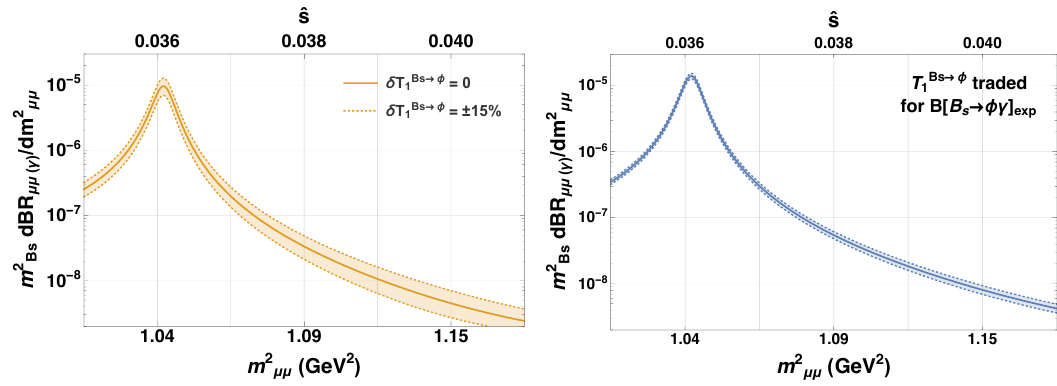
Figure 3 . Di(cid:11)erential branching ratio for B 0 ! (cid:22) + (cid:22) (cid:0) (cid:13) around the (cid:30) (1020) resonance, with (left s 0 from eq. (3.5), and with (right panel) the (cid:30) -peak region constrained from the present panel) g B s ! (cid:30) + experimental measurement of B ( B 0 ! (cid:30)(cid:13) s